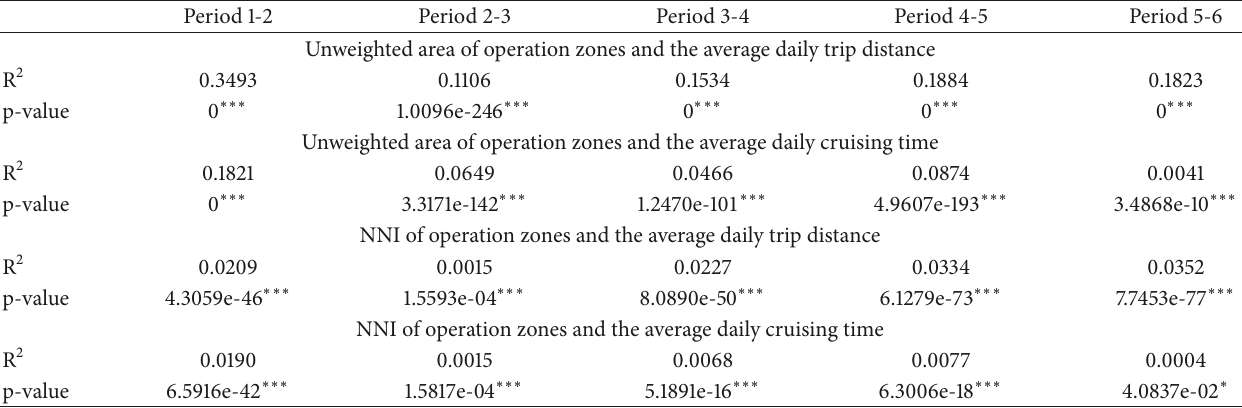
Table 5: The R 2 and p-value for the correlation analysis between the change in the operation zones and the change in the average daily trip distance or average daily cruising time in each